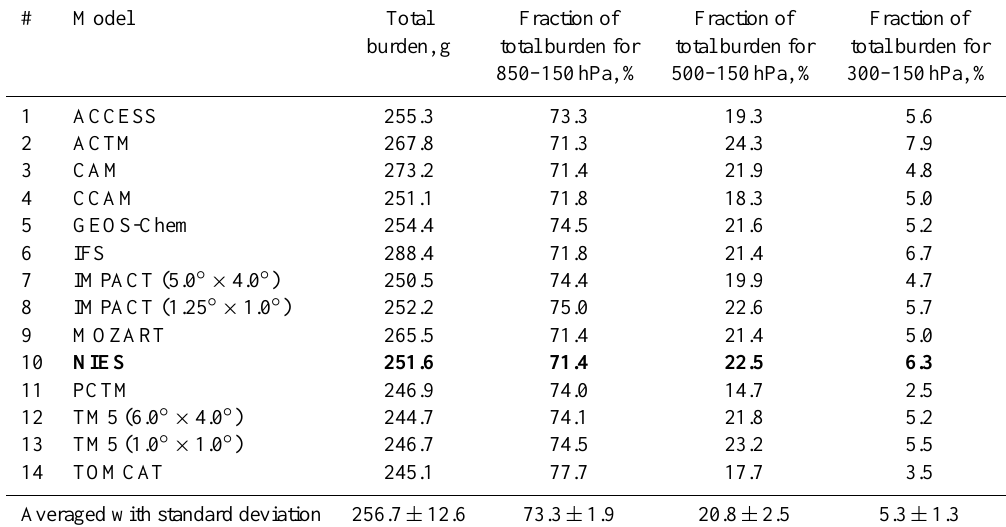
Table 3. The total 222 Rn burden (in g) and upper tropospheric fractions of the total radon burden (in %) averaged over a